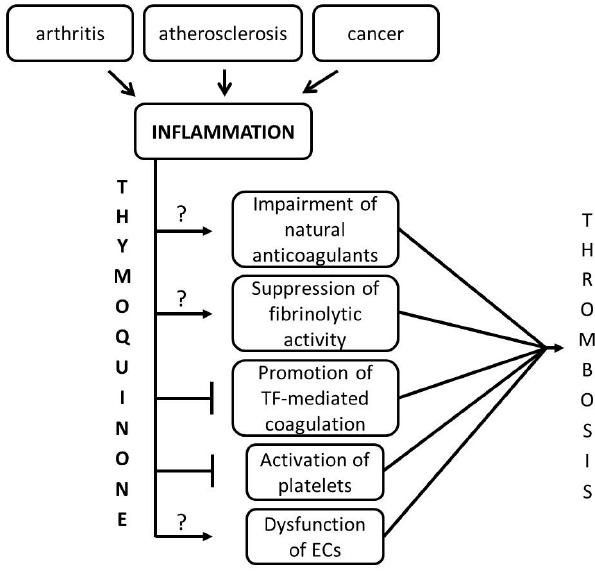
Figure 6. THQ interferes with the crosstalk between inflammation and thrombosis. Inflammation is triggered under various pathophysiological conditions in the body such as arthritis, atherosclerosis, and cancer. An increase in blood coagulation or thrombosis is seen in all of these conditions. Inflammation-triggered cytokines, particularly TNF- α , IL-1, and IL-6, enable a cascade of events, culminating in thrombosis. We provide evidence in this study that THQ can effectively inhibit tissue factor (TF)-mediated coagulation and inactivation of platelets that lie in the crosstalk between inflammation and thrombosis. The effect of THQ on natural anticoagulants, endothelial cells (ECs), and fibrinolytic activity could not be investigated in this study due to limitations of the in vitro system; this is represented by ‘?’. In addition, THQ also exerts an effect, although moderate, on the factor Xa activity of the blood coagulation system.